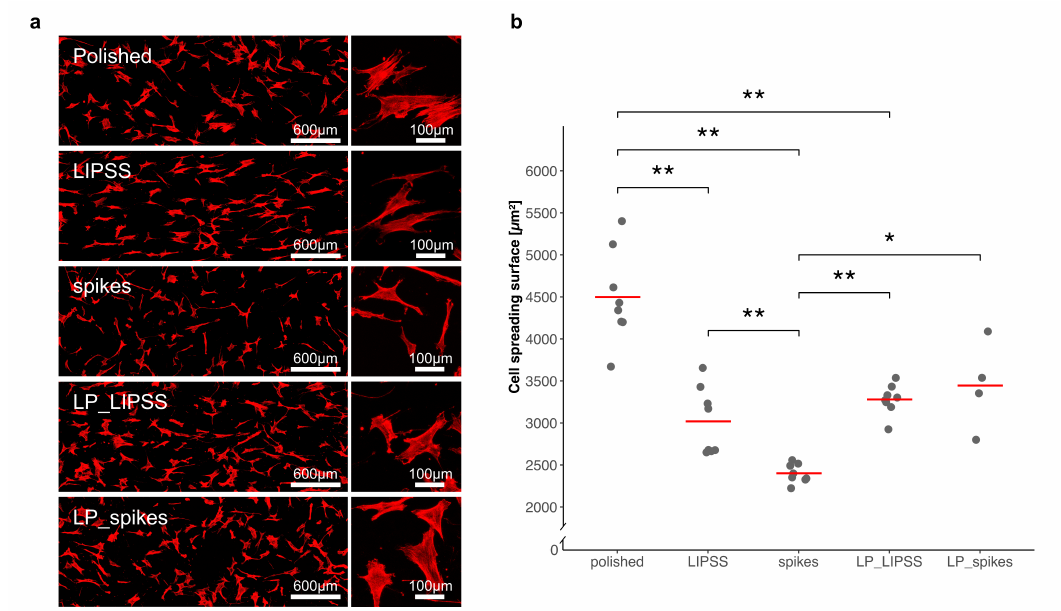
Figure 3. Quantification of cell spreading areas on polished, laser-nanostructured and laser-patterned surfaces. ( a ) Cytoskeleton staining images representing human mesenchymal stem cells (hMSCs) spreading 24 h after seeding on the five di ff erent surfaces previously sterilized. The rectangular graphs on the left are global views at a low magnification, and the square graphs on the right are representative cells at a high magnification; ( b ) four di ff erent areas of each surface were analyzed and, except for LP_spikes, the displayed data corresponds to duplicates of each condition (each dot represents the mean of more than 30 cells per area). The red lines denote mean values. The Kruskal–Wallis test followed by Mann–Whitney pairwise comparison with Bonferroni correction was performed. * p -value < 0.05, ** p -value <